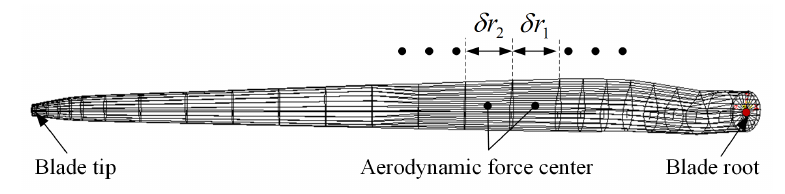
Figure 3. Schematic of blade